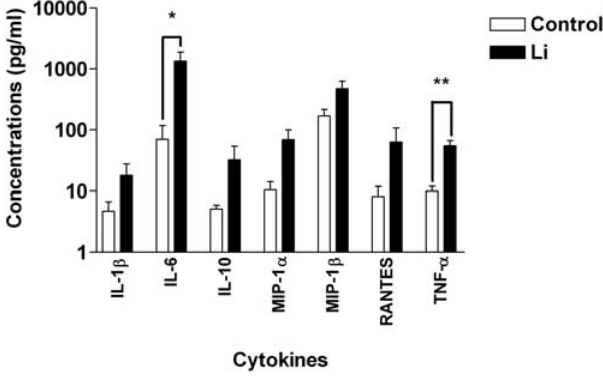
Figure 6. Leishmaniainfantum amastigotes promote secretion of IL-6 and TNF- a . iDCs were either left unexposed (Control) or exposed to Leishmania infantum amastigotes (Li) for 24 h. Cell-free supernatants were collected and analyzed with a Bio-Plex assay. The results shown are representative of five separate experiments performed with different donors. Asterisks denote statistically significant differences from the uninfected cells (P , 0.05; **, P , 0.01).